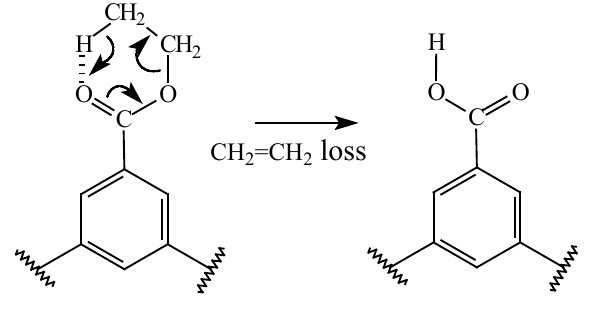
Scheme 1: Loss of an ethylene molecule through McLafferty’s